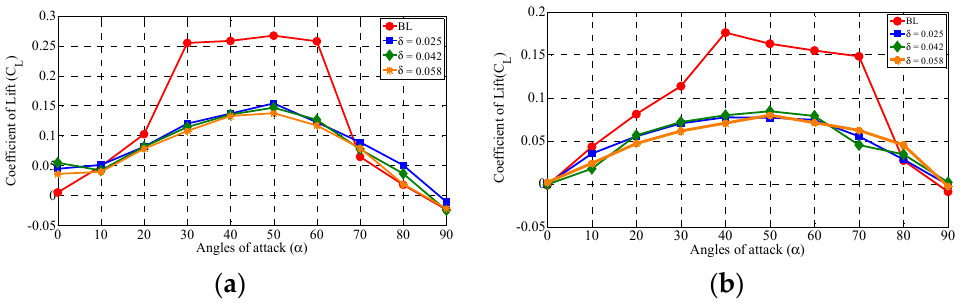
Figure 12. The aerodynamic behavior of lift coefficient for different circular slot ratios and various angles of attack at ( a ) θ = 30° and ( b ) θ = 60°.